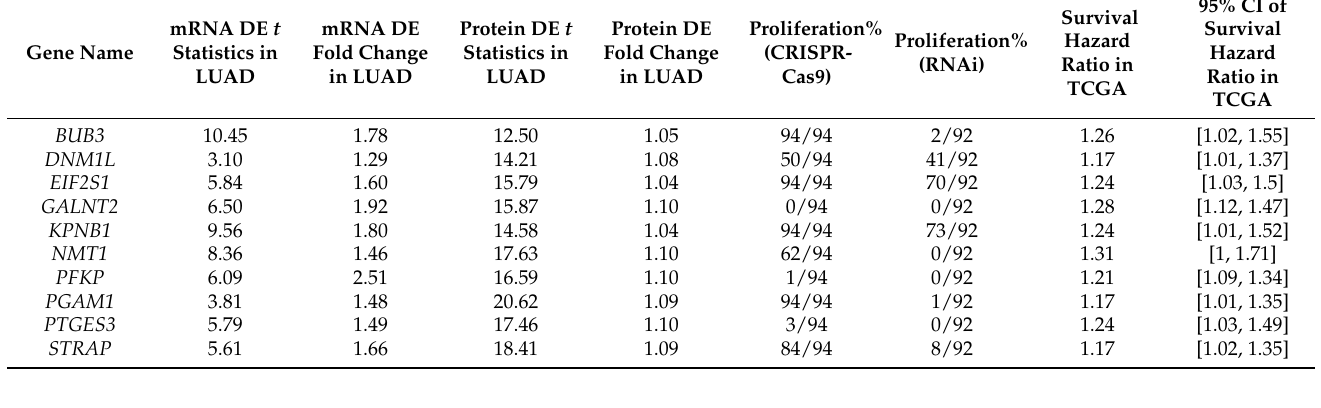
Table 7. Selected hub genes that were significant in all measurements of tumorigenesis and patient survival. LUAD: Xu’s LUAD cohort [39]. DE: differential expression. Fold change: tumor/NATs. The percentage in proliferation results represented the number of cell lines with a dependency score < − 0.5 divided by the total number of tested human NSCLC cell lines in CRISPR-Cas9/RNAi screening. CI: confidence interval.